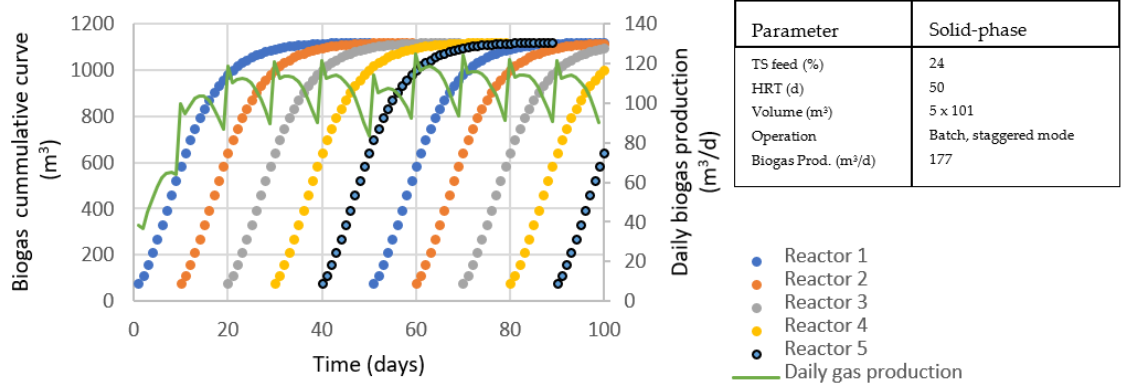
Figure 8. Expected biogas flow of a solid-phase batch reactor operating under a staggering mode. A 20% decrease in biogas yield was assumed, with regard to that obtained from BMP tests. Data for a solid-phase plant of equivalent treatment capacity to that of wet digestion are also presented.